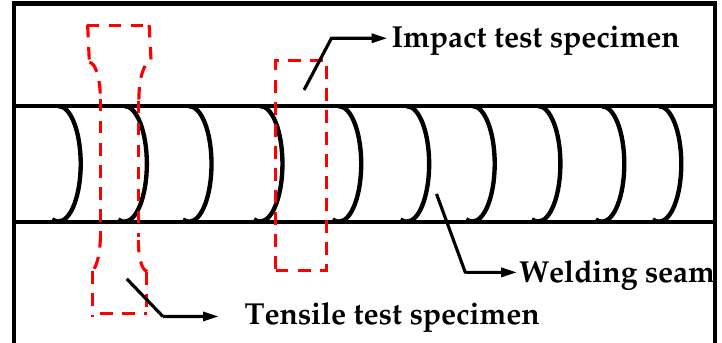
Figure 4. Schematic diagram of machining orientation of tensile and impact test specimens.